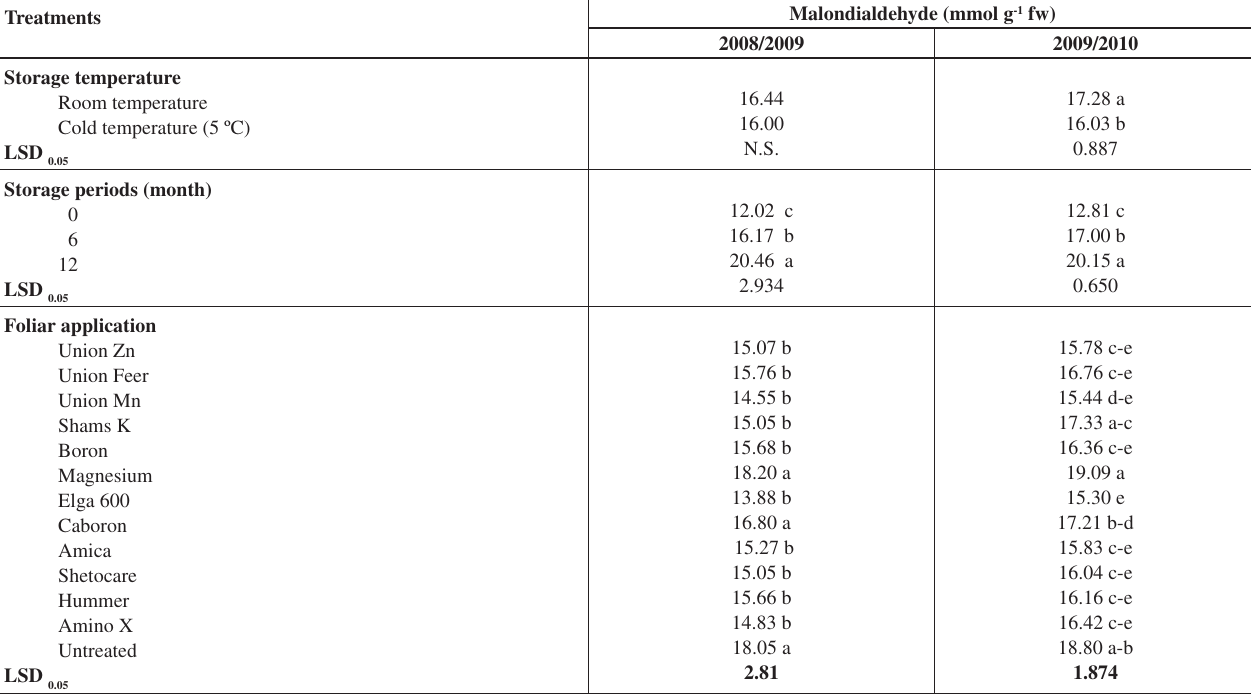
Table 23: Effect of storage temperature, storage period and foliar application with commercial compounds on malondialdehyde content of onion seeds during seasons of 2008 / 2009 and 2009/2010